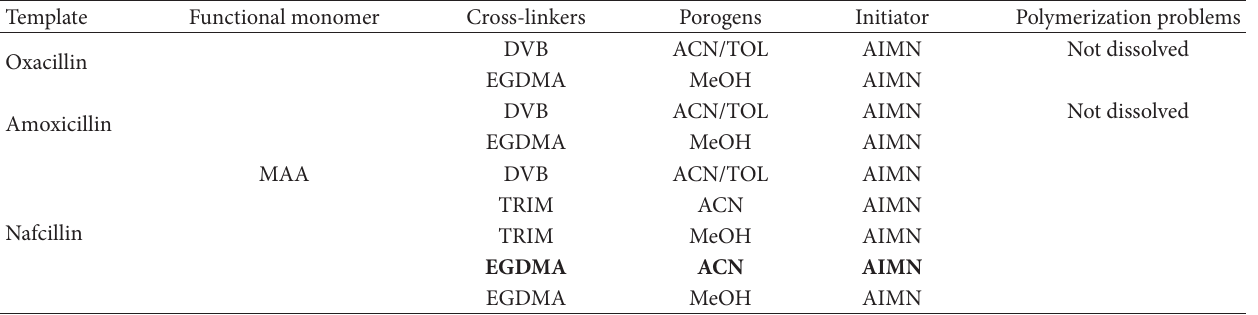
Table 2: Composition of different MIP synthesized for the simultaneous extraction of penicillin drugs.